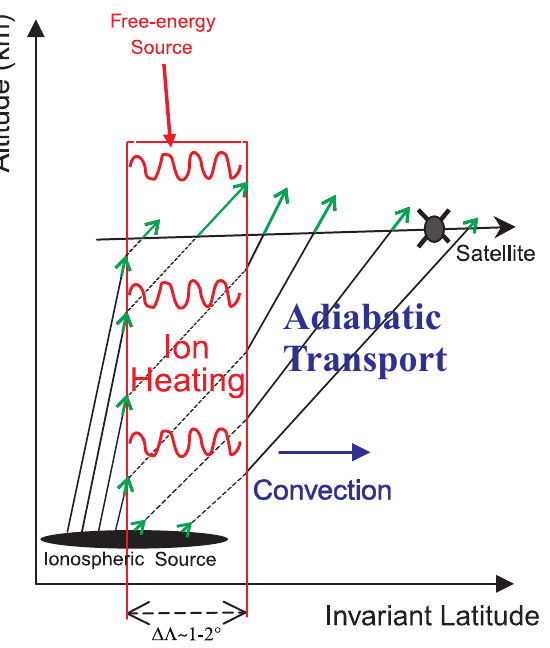
Fig. 1. Two-dimensional (invariant latitude-altitude) sketch that il- lustrates the transport patterns of ion outflows from an ionospheric source of finite latitudinal extent 13 throughout the cusp/cleft and dayside polar cap, in conjunction with a high-altitude satellite pass. The green vectors correspond to the ion velocities and their lengths are proportional to their